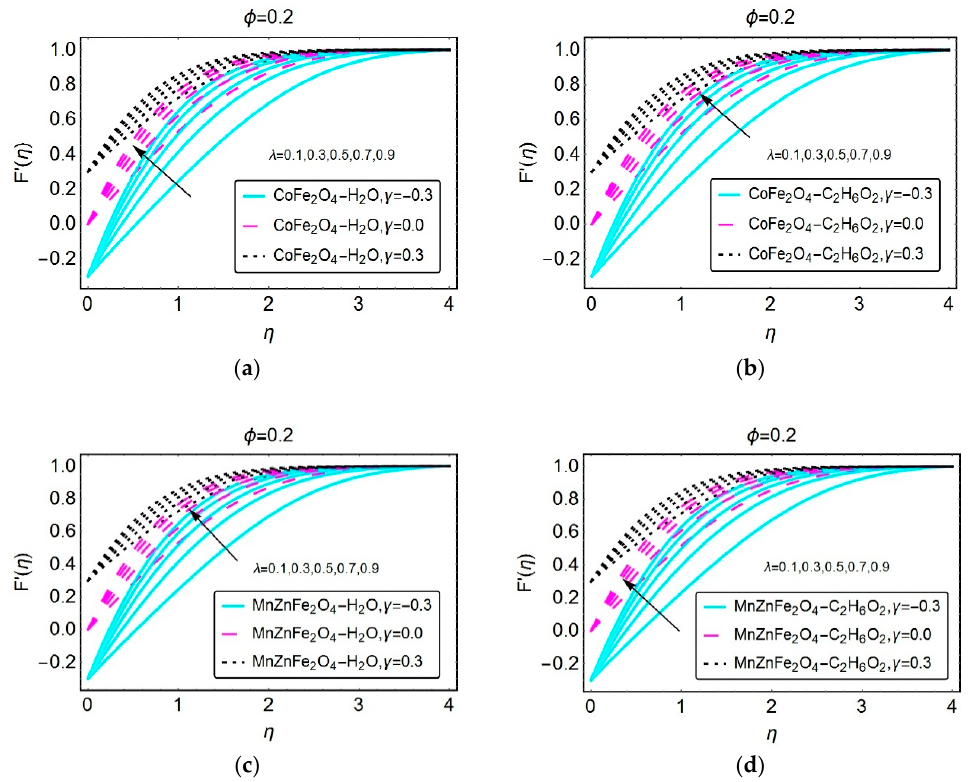
Figure 2. Alterations in the velocity distribution for ( a ) CoFe 2 O 4 − H 2 O; ( b ) CoFe 2 O 4 − C 2 H 6 O 2 ; ( c ) MnZnFe 2 O 4 − H 2 O; ( d ) MnZnFe 2 O 4 − C 2 H 6 O 2 nanofluids by varying λ